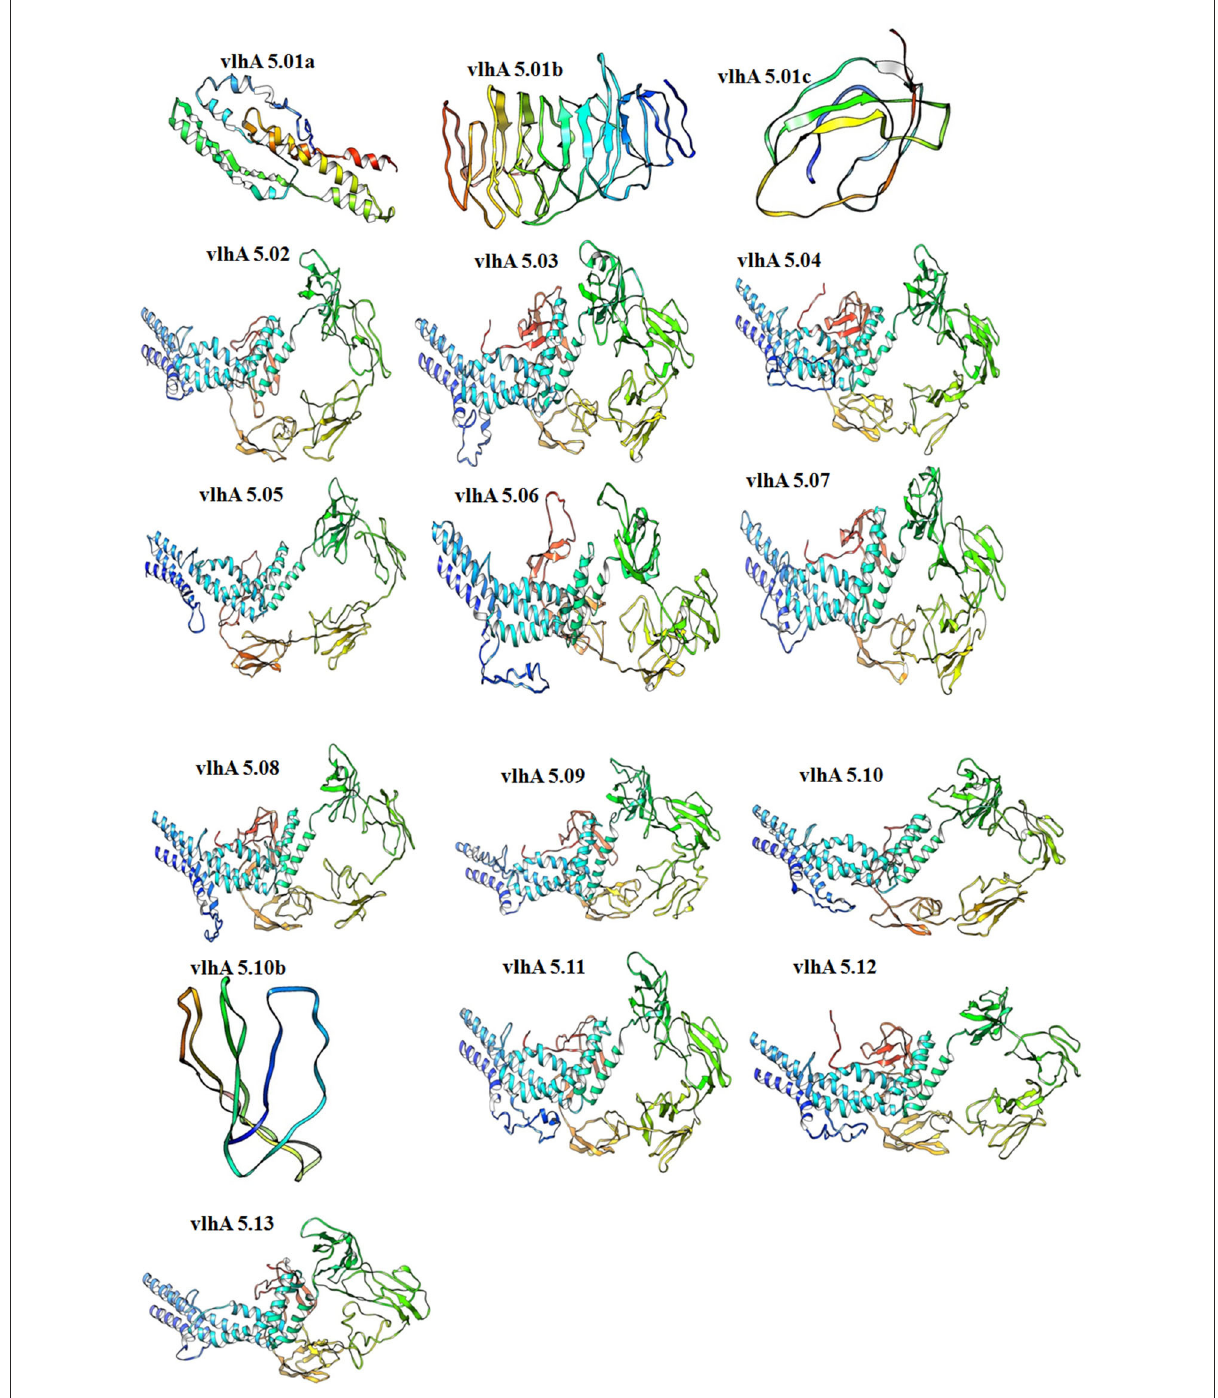
FIGURE4 Three-dimensional ab initio models of vlhA proteins. Visualizations of model structures were performed by UCSF Chimera.